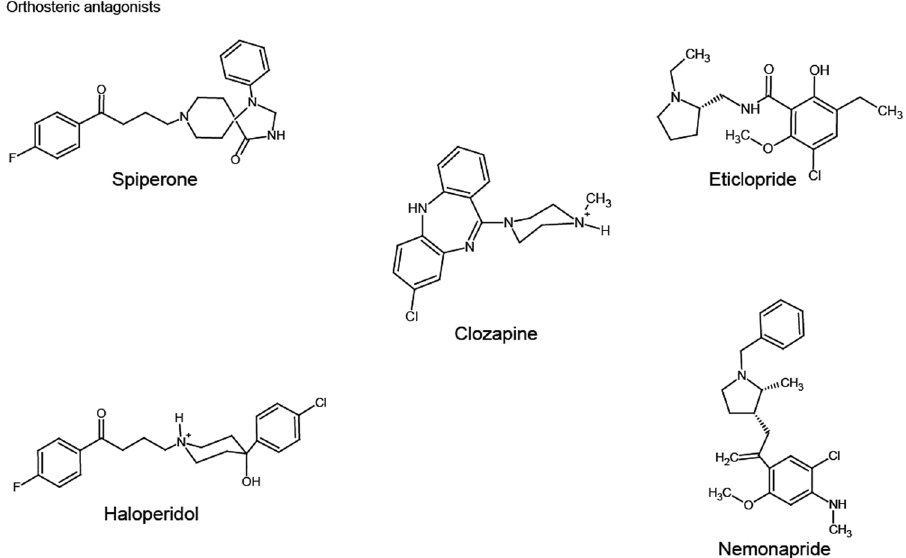
Figure 5. Structure of dopamine receptor antagonists. The chemical structures of the dual D 2 /D 3 orthosteric antagonists, spiperone, haloperidol, eticlopride, nemonapride and clozapine are shown.